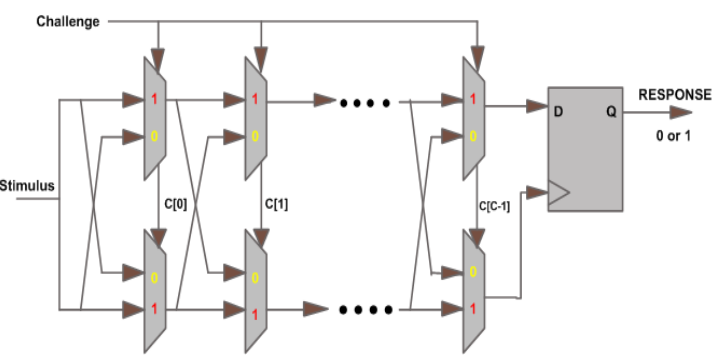
Figure 2. Arbiter PUF (APUF)